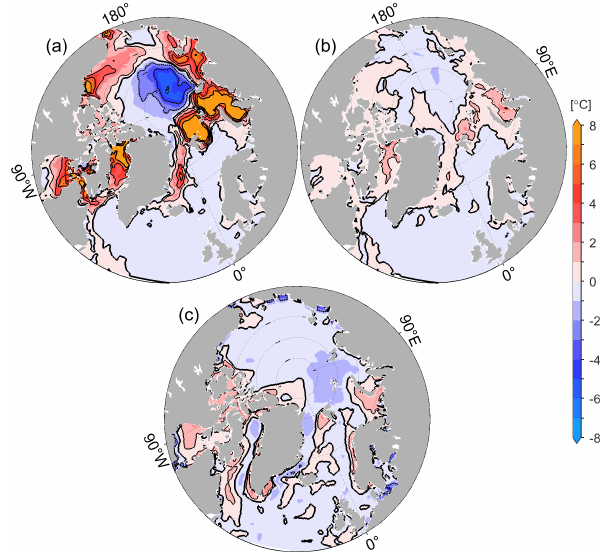
Figure 11. Adjustments of the 2m air temperature averaged from 20 May to 15 June 2012, in (a) adjoint-FD and (b) adjoint-VP. Panel (c) shows the 2m air temperature differences between the ERA5 and NCEP-RA1 reanalyses (ERA5 minus NCEP-RA1) av- eraged from 20 May to 15 June 2012. The contour intervals are 2 ◦